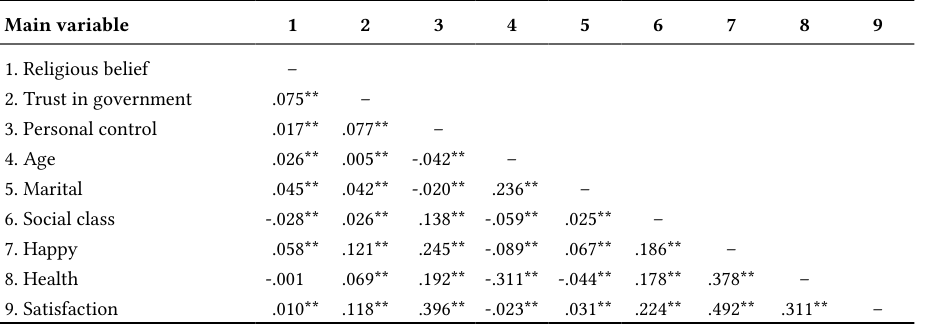
Correlations Between Main Variables at Level